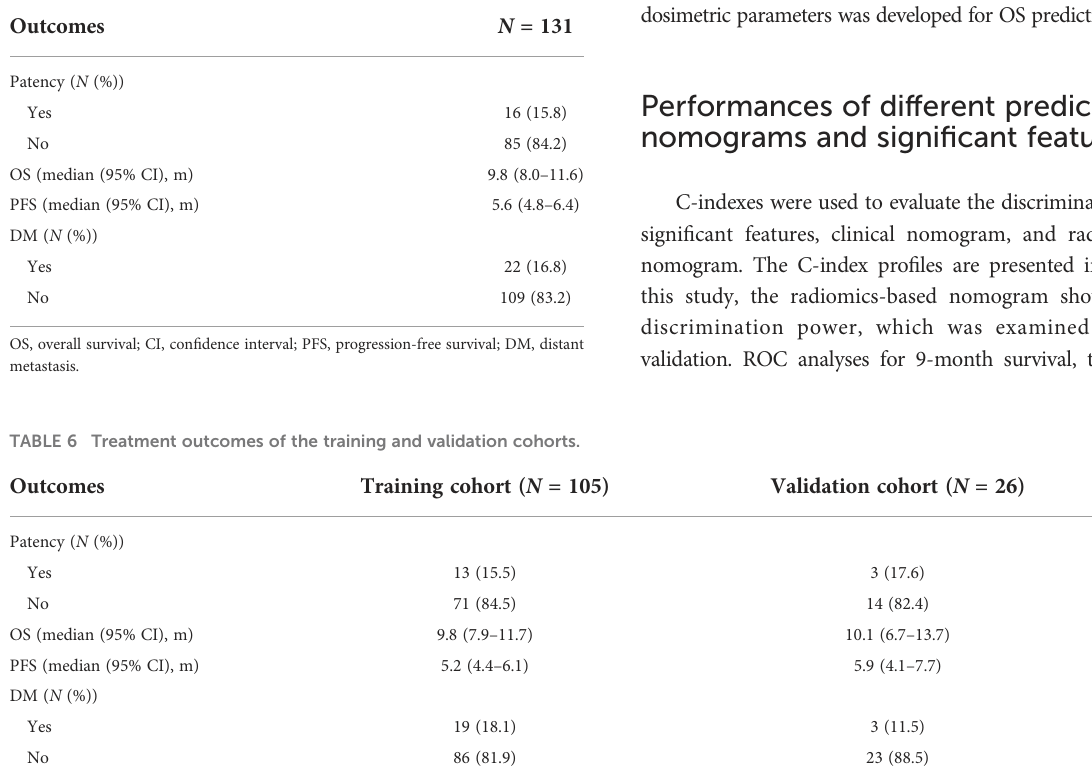
TABLE 5 Treatment outcomes of all patients.